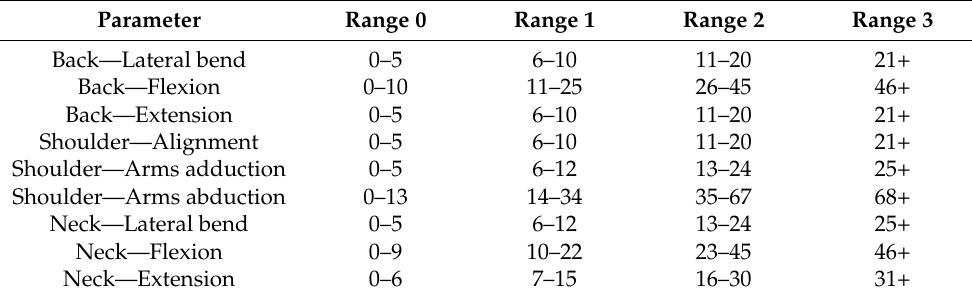
Table 1. Range (in degrees) of motion zones (0 to 3) for some of the parameters used to quantify the body